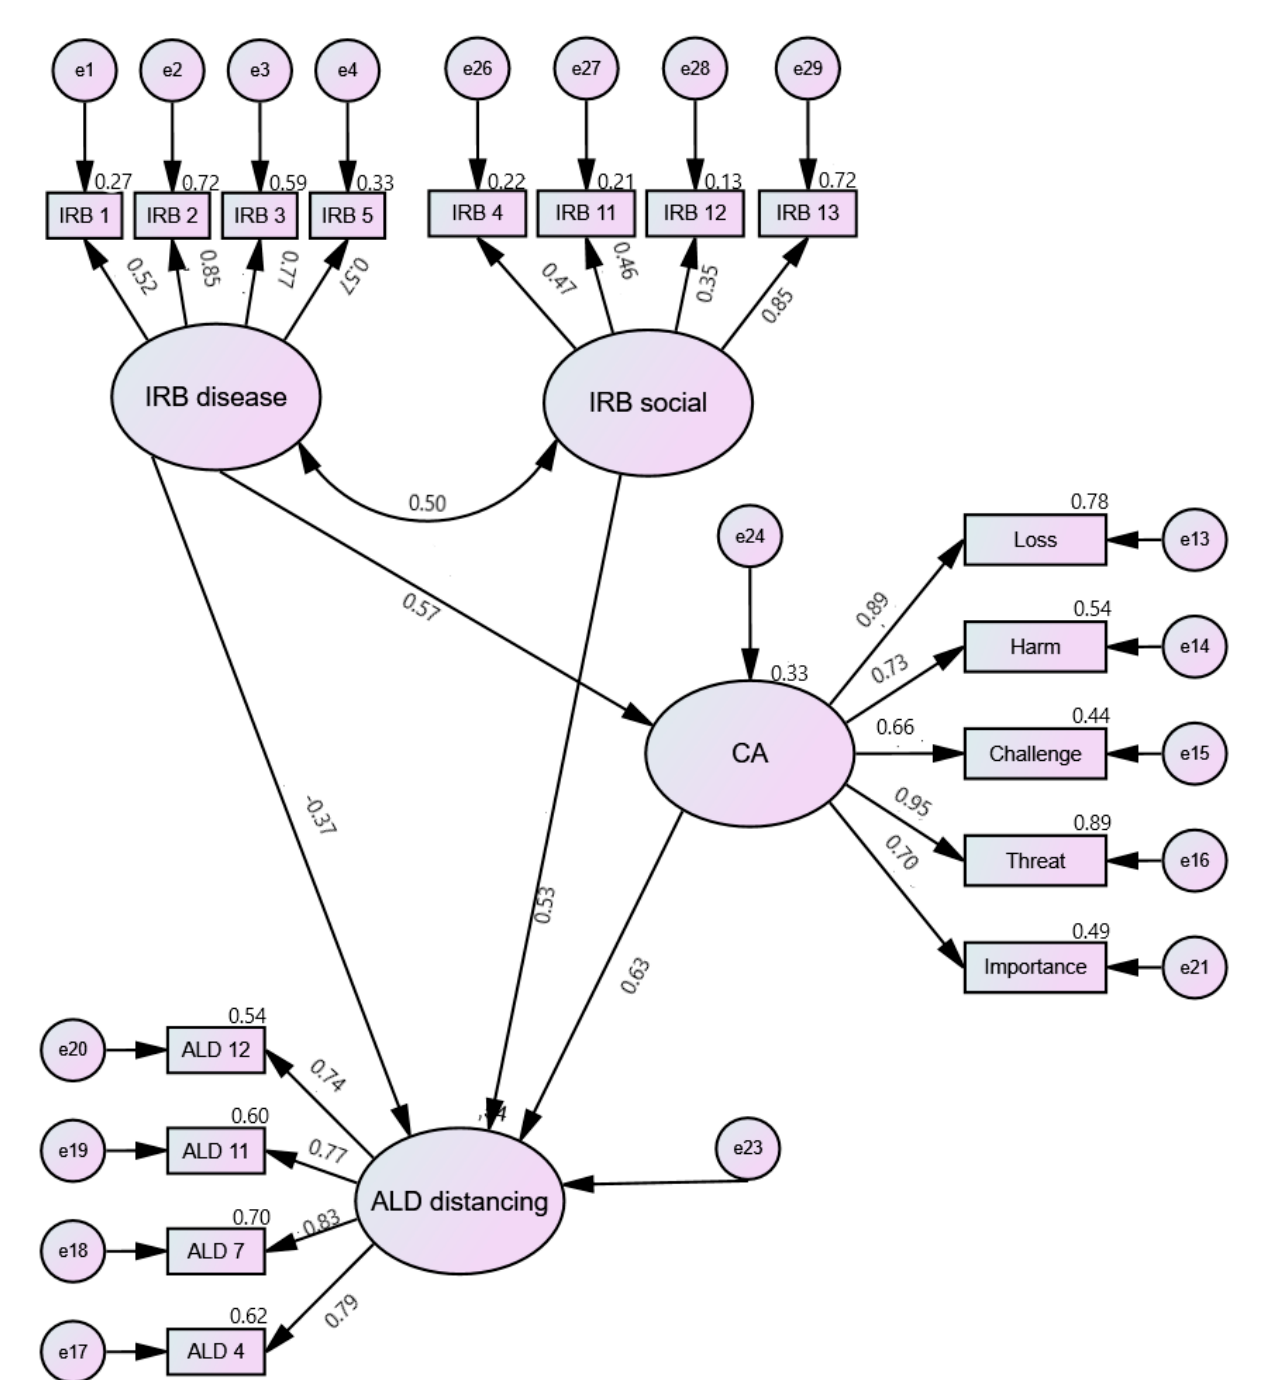
Figure 4. Cognitive factors and ALD Distancing: Path diagram. IRB—Illness-related Beliefs; CA— Cognitive Appraisal; ALD—Acceptance of Living with the Disease.